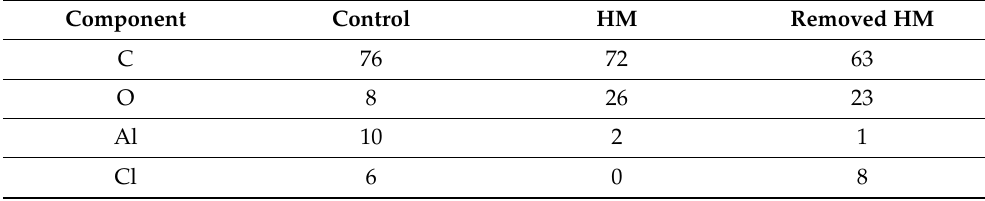
Table 2. Floor surface composition. Elemental ratios in percentage analyzed by the SEM-EDX with a rectangle area of approximately 40 × 60 µ m 2 with a magnification of 2000 are listed for control, HM, and removed HM. The chlorine originated from the PVC base polymer of the floor tile. Component Control HM Removed HM C 76 72 O Al